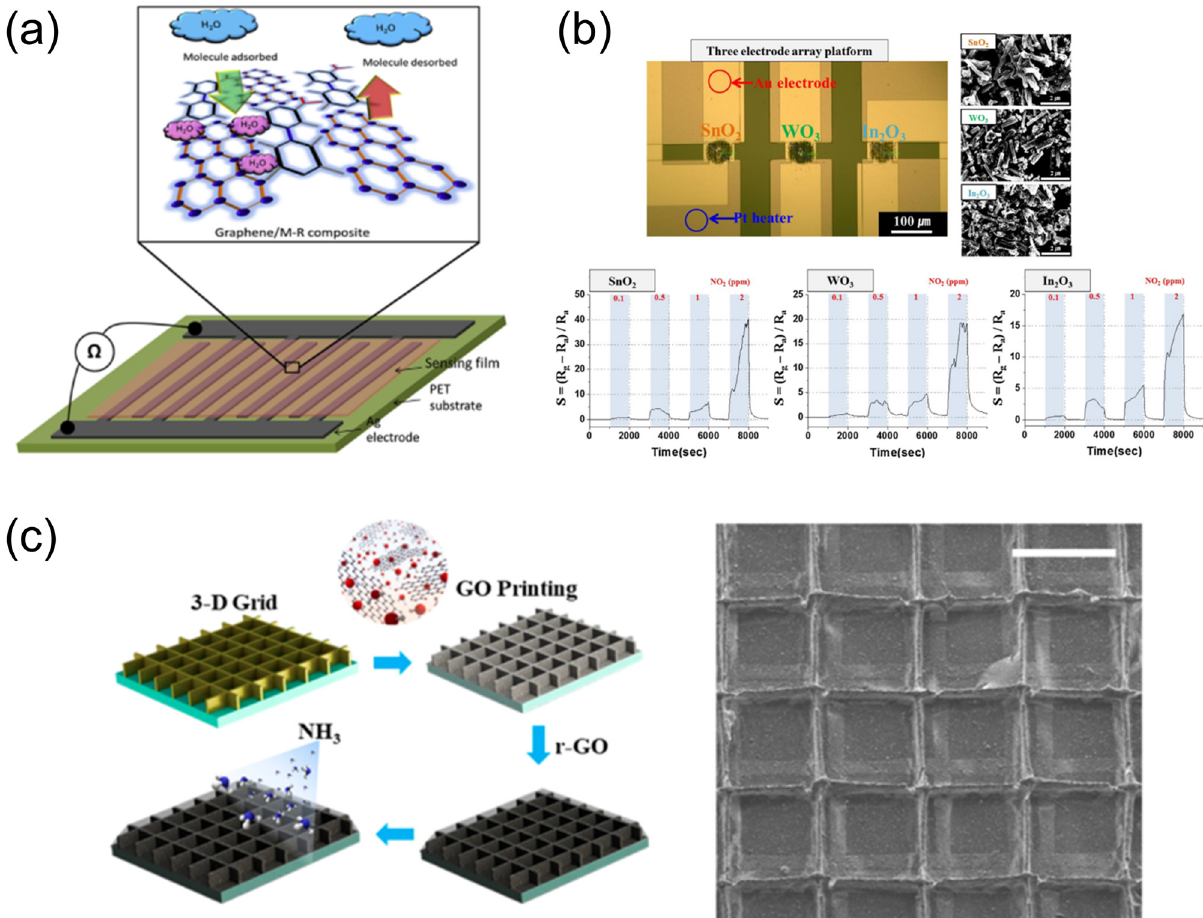
Figure 14: ( a ) A schematic diagram of a humidity sensor and an illustration of the phenomenon of water vapor interacting with the surface of the sensor. Reproduced from ref. [ 152 ] with permission from Elsevier Ltd. ( b ) Three gas sensor arrays made of SnO 2 , WO 3 , and In 2 O 3 materials. The sensing results of three kinds of sensors for NO 2 . Reproduced from ref. [ 157 ] with permission from Elsevier. ( c ) The structure diagram 3D ammonia sensor. Reproduced from ref. [ 159 ] with permission from MDPI ( Basel, Switzerland )